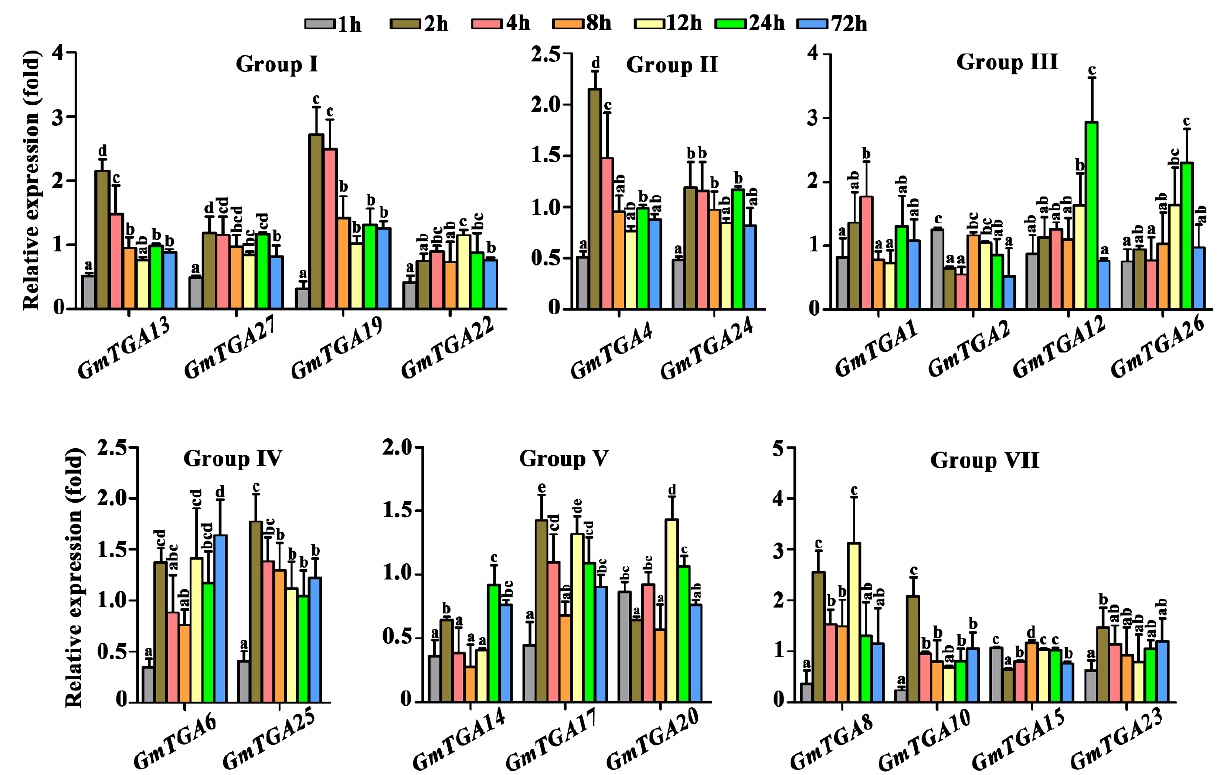
Figure 2. Expression profiles of GmTGA genes of soybean NN1138-2 following infection with SMV at 1, 2, 4, 8, 12, 24 and 48 h post-inoculation (hpi). RNAs isolated from non-inoculated and inoculated unifoliate leaves of soybean were employed to analyze the expression of 7 groups of GmTGA genes using qRT-PCR. The relative expression levels were calculated by comparing the gene-expression values in inoculated vs. non-inoculated unifoliate leave tissues using the 2 − ∆∆ Ct method. The data are presented as mean ± standard deviation from three independent experiments. Relative quantitative values in the same gene with different letters are significantly different at p = 0.05 level.